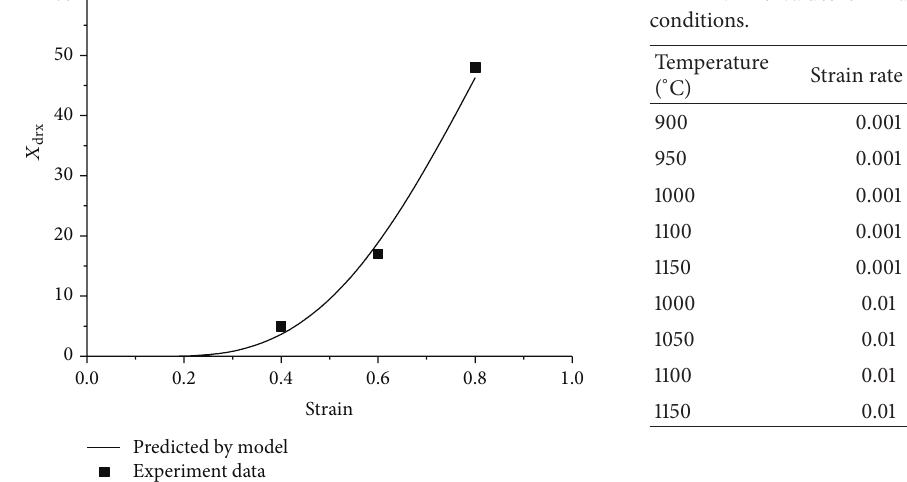
Table 1: The values of 𝑍 and 𝐷